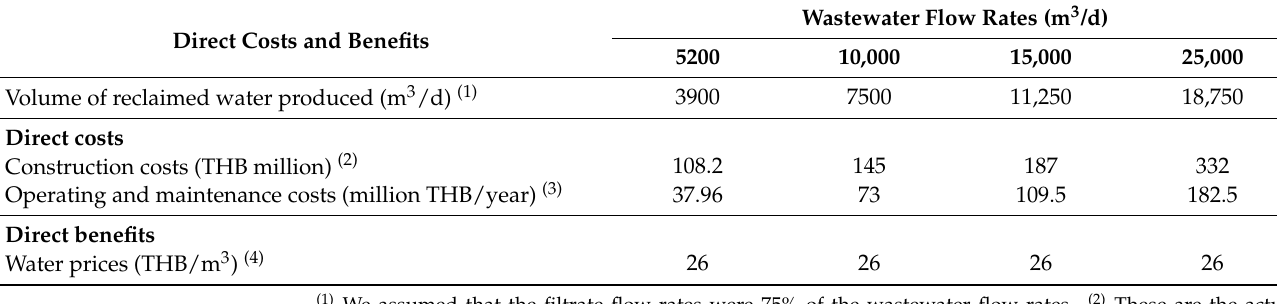
Table 1. Information for estimating the direct costs and benefits of water reclamation projects for industrial water supply, consisting of ultrafiltration and reverse